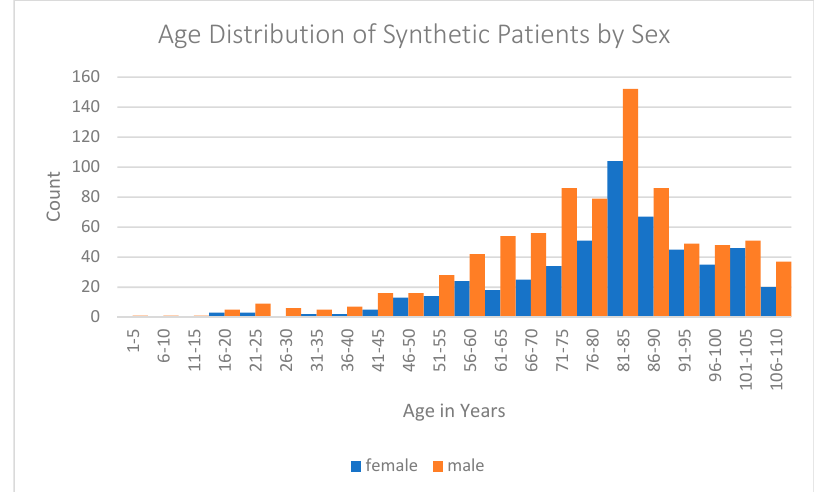
Figure A1. Distribution of synthetic patients by age grouping.